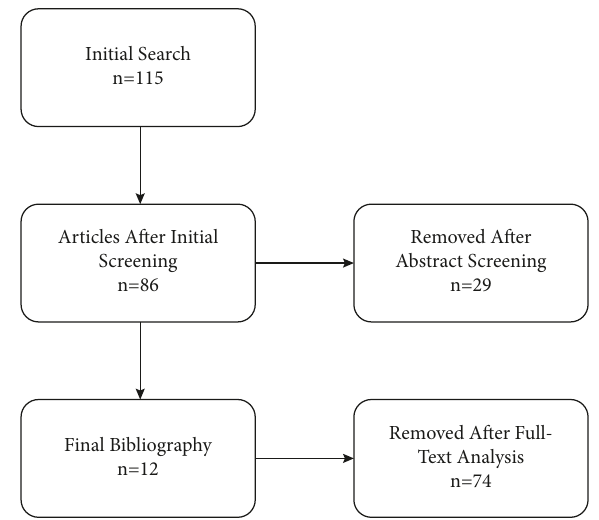
Figure 1: A fowchart describing the search